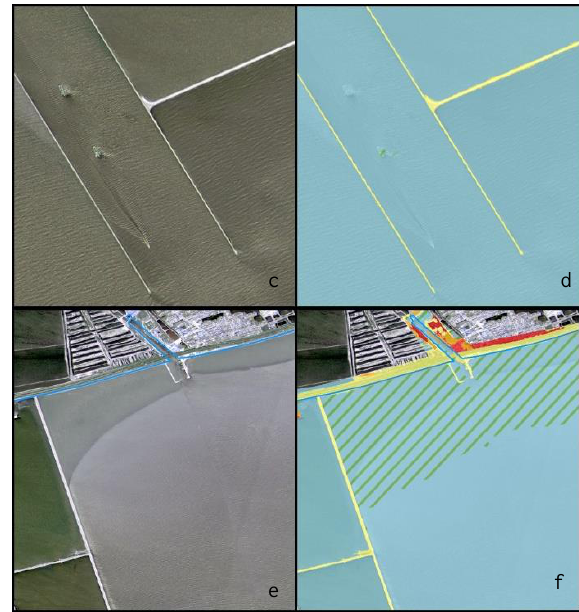
Figure 4. The comparison between ground truth of several regions and their classification